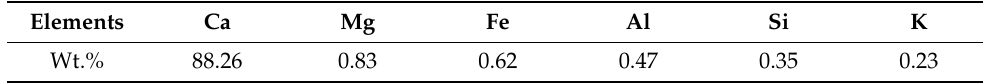
Figure 1. ( a ) XRD of raw quicklime; ( b ) XRD of digested sample; ( c ) particle size distribution of quicklime; ( d ) SEM; ( e ) the flow chart of the sample production processes. Table 1. XRF element analysis of dried quicklime samples